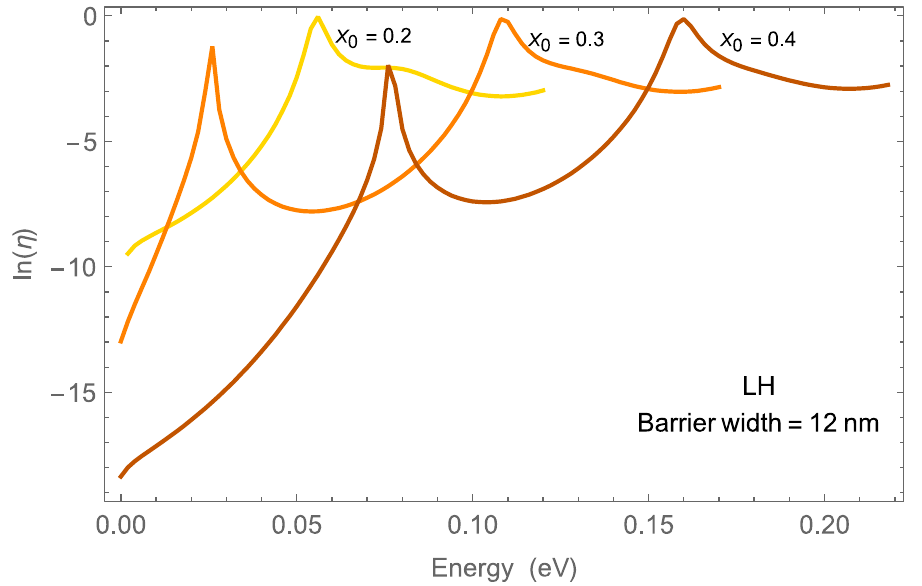
Figure 11. Logarithm of the transmission coefficient for LH as a function of energy for the double- barrier In x Ga 1 − x N/GaN parabolic quantum well structure with various x 0 at an applied bias of 0.8 V, and barrier width 12